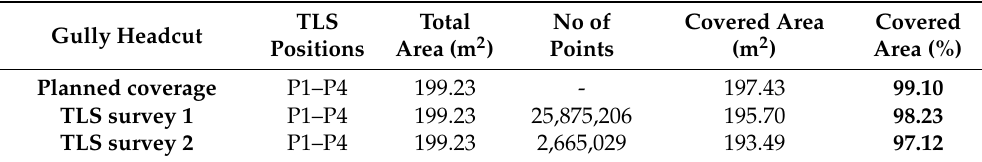
Table 3. Difference in total planned and achieved coverage for both TLS surveys over gully headcut (SA-2). TLS Total No of Covered Area Covered Gully Headcut Positions Area (m 2 ) Points (m 2 ) Area (%) Planned coverage P1–P4 199.23 - 197.43 99.10 TLS survey 1 P1–P4 199.23 25,875,206 195.70 98.23 TLS survey 2 P1–P4 199.23 2,665,029 193.49